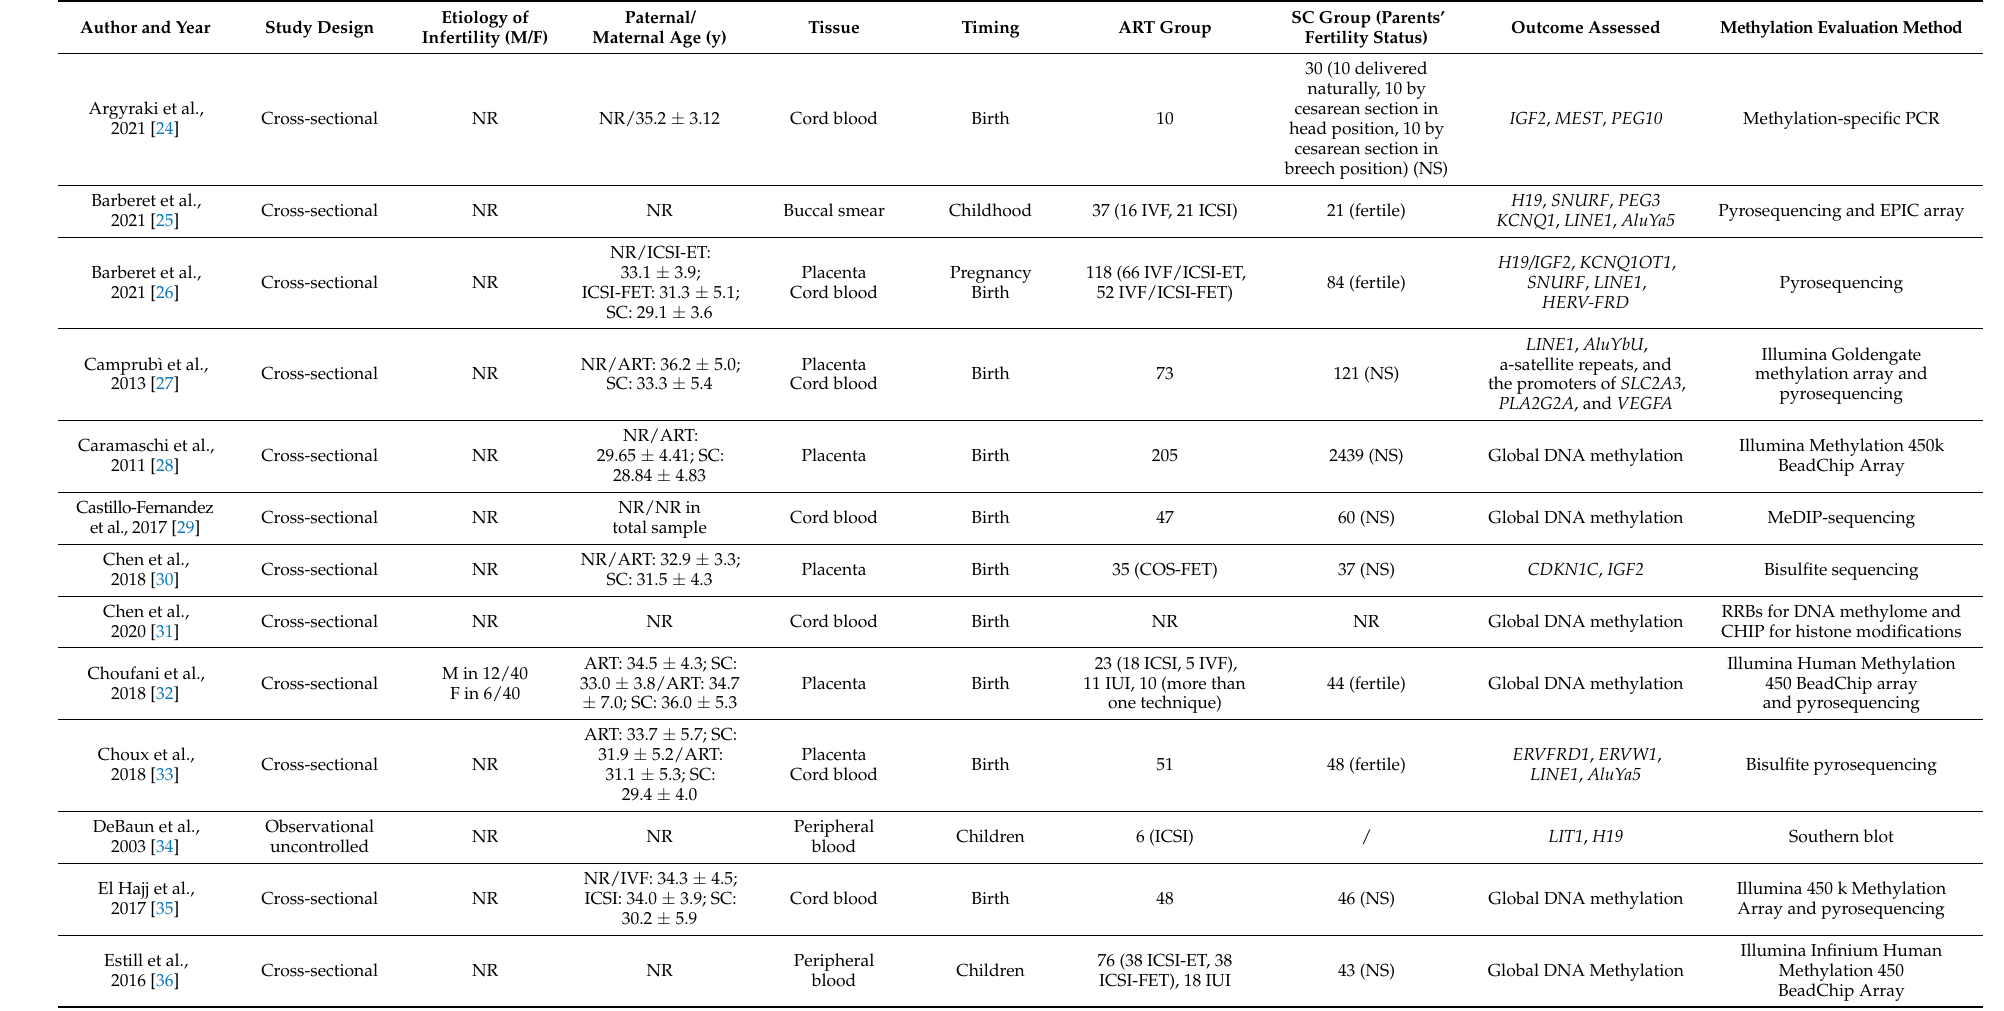
Table 2. Main features of the included